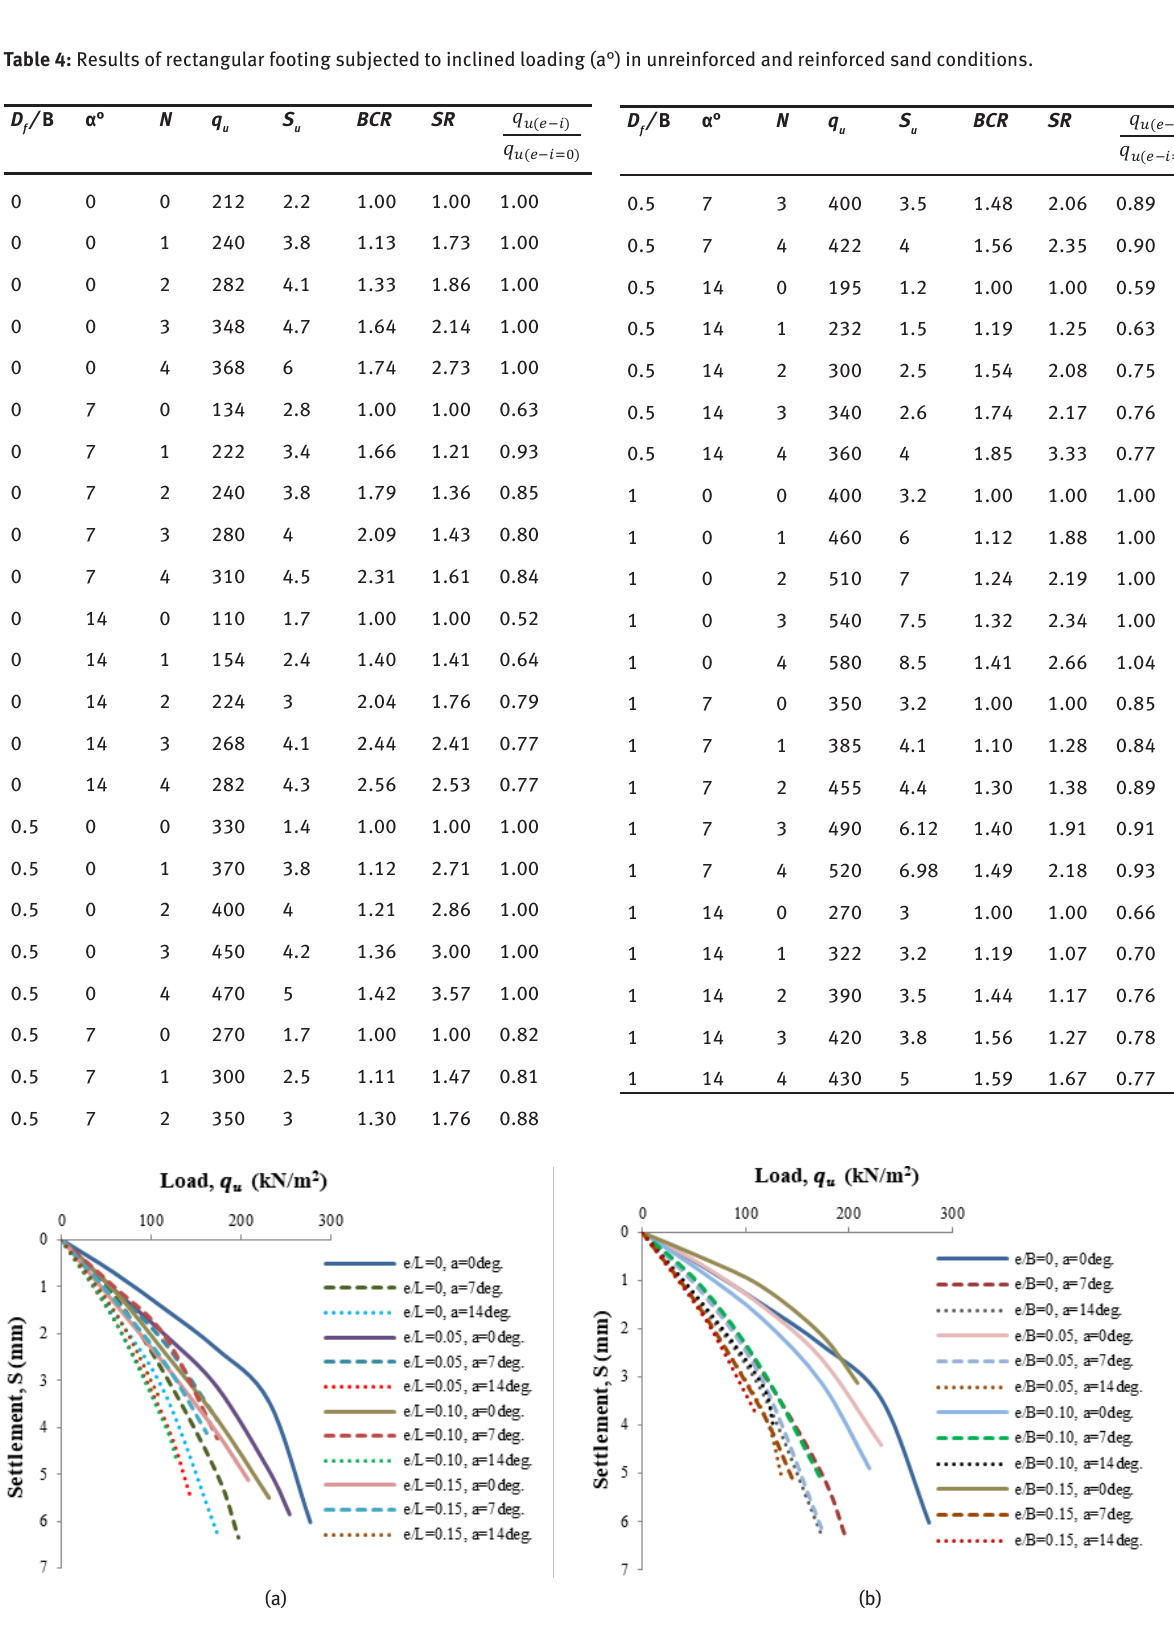
⁄ B =0 ) at eccentric-inclined loading along with (a) larger dimension ( e/L , a) and (b) smaller f